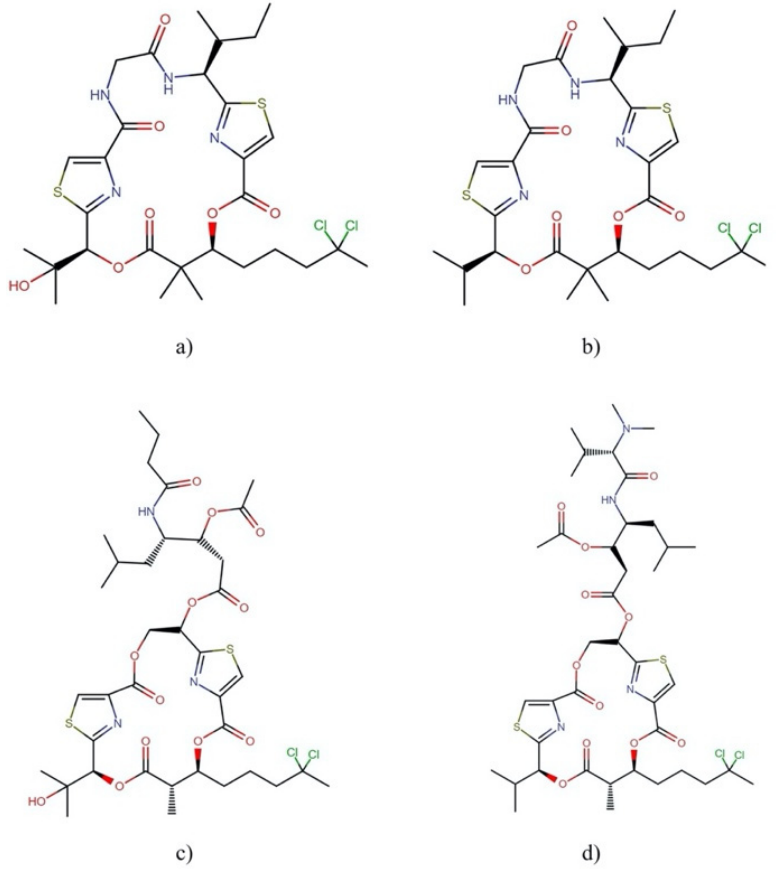
Figure 17. Chemical structures of the most representative lyngbyabellins: ( a ) lyngbyabellin A, ( b ) 27-deoxylyngbyabellin A, ( c ) lyngbyabellin E, and ( d ) lyngbyabellin N. All molecules from this family are shown in Supplementary Figure S3.